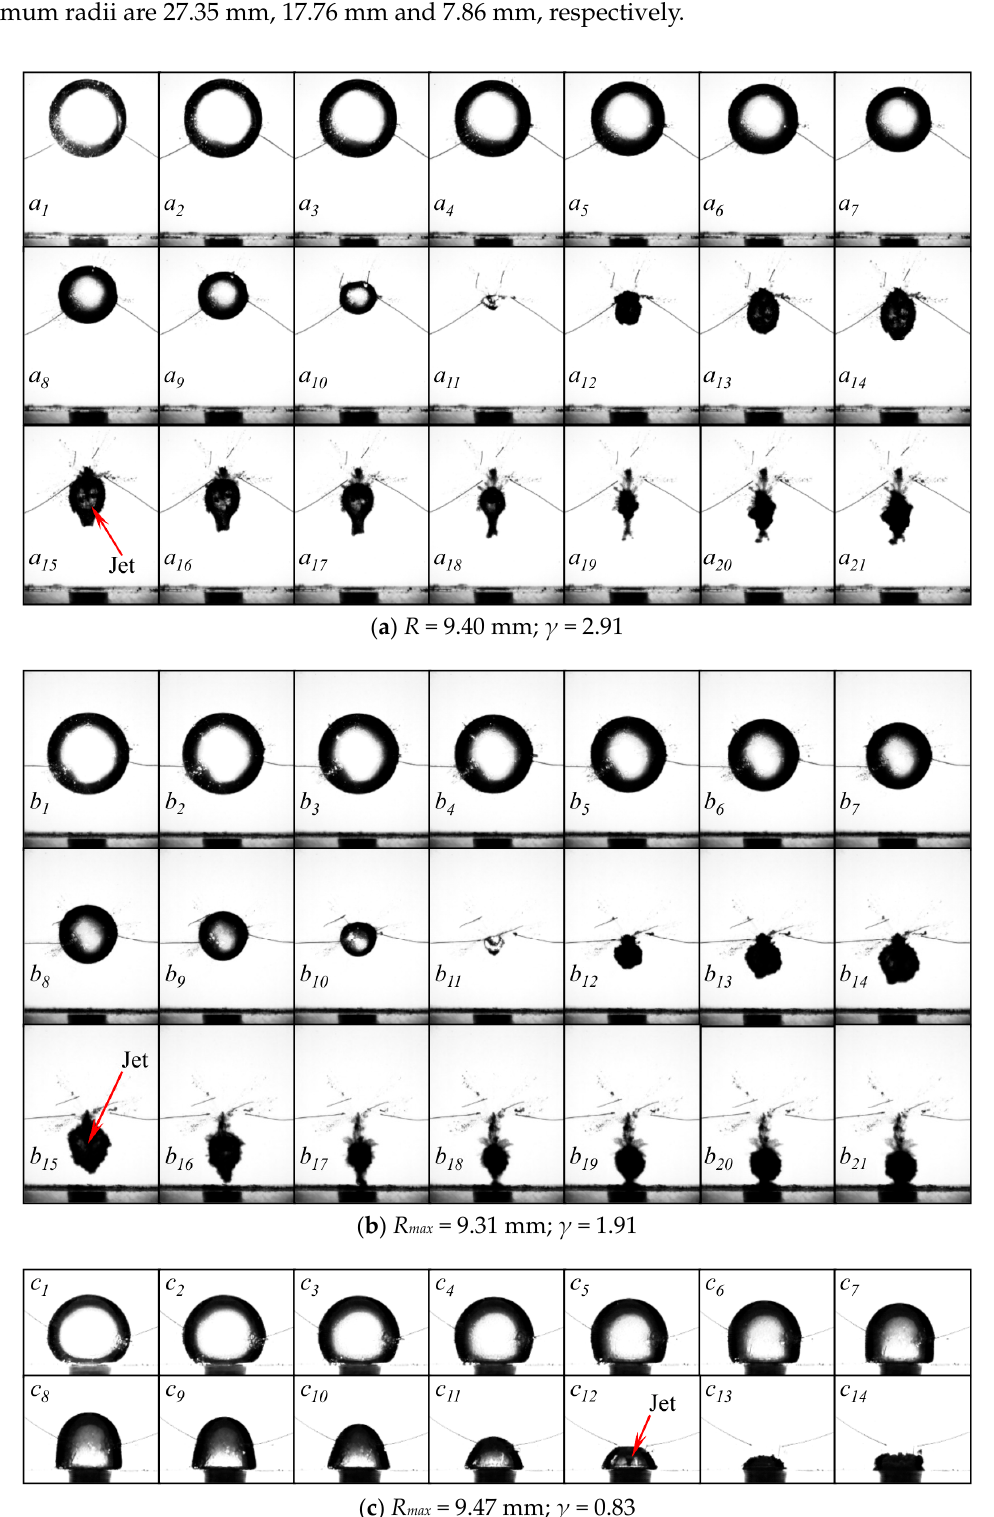
Figure 3. High-speed photographic images of the cavitation bubbles in the contraction collapse stage under the conditions of different distances γ (frame-rate: 150,000 fps; exposure time: 5.06 μ s; frame width: 32.00 mm).